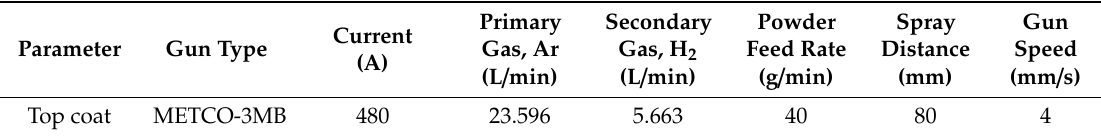
Figure 2. Schematic diagram of coating designs: ( A ) a conventional thermal barrier coating (TBC) (sample A), ( B ) a crack ‐ healing TBC with a buffer layer (sample B), and ( C ) a crack ‐ healing TBC with encapsulated agents (sample C). YSZ = yttria ‐ stabilized zirconia. Table 1. Parameters of air plasma spraying.